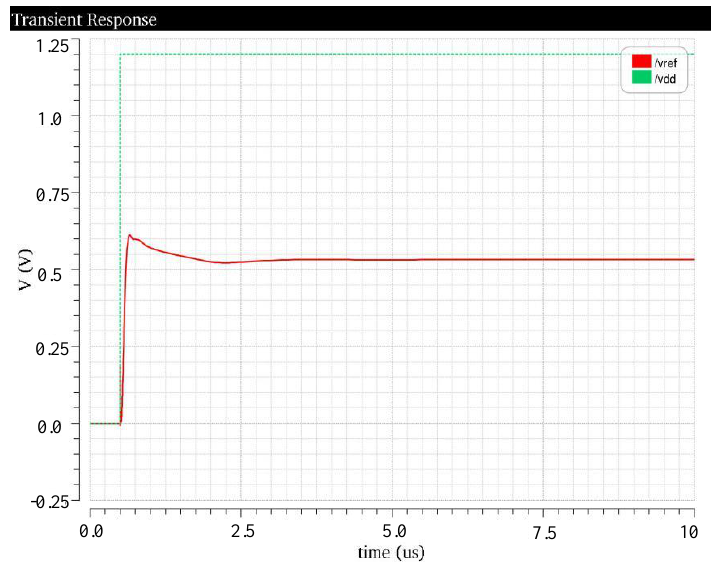
Figure 12. Start-up time (reference